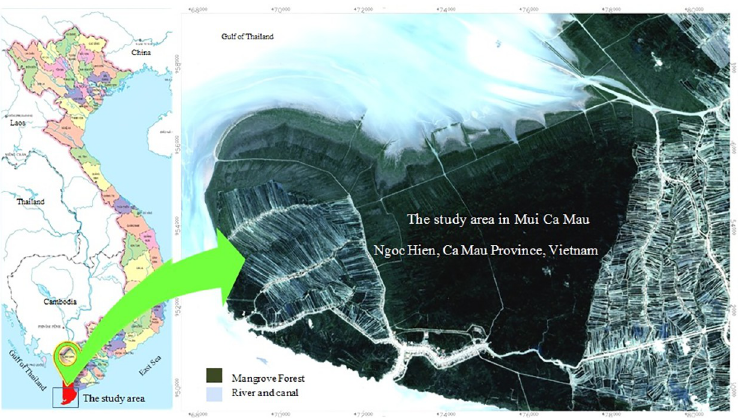
Fig 1. Study area (republished satellite data under a CC BY license, with permission from the Department of Remote Sensing, Ministry of Natural Resources and Environment of Vietnam, original copyright [1995, 2004,